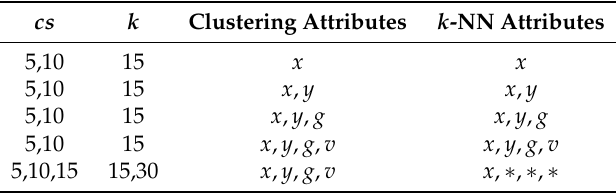
Table 4. Parameters for the second experiment of N = 2000